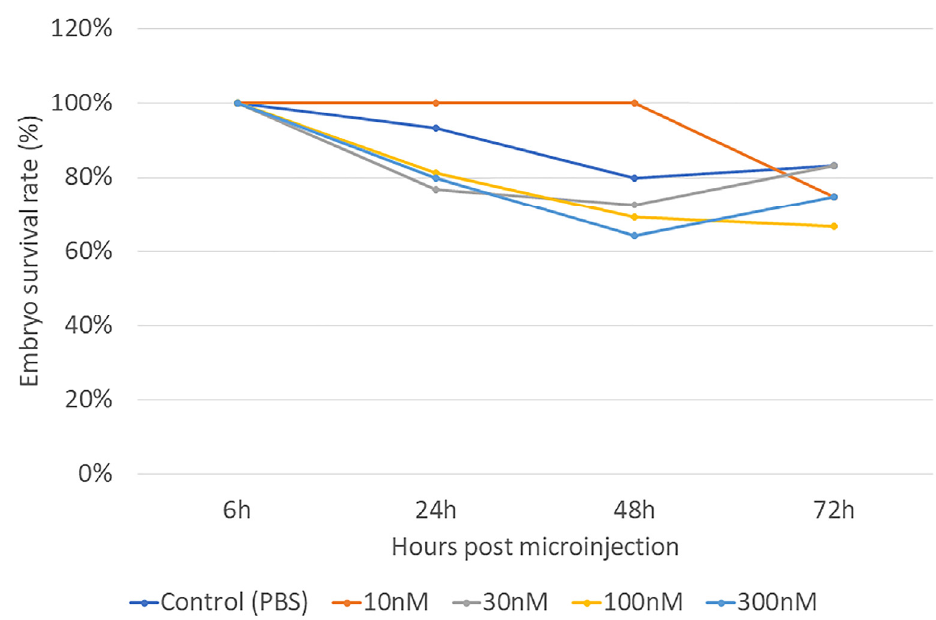
Figure 2. Embryo viability rate in the presence of different H 2 O 2 concentrations 6 h, 24 h, 48 h, and 72 h post-injection. The embryo survival rate was used to determine the toxicity level of the injected concentrations of H 2 O 2 . The results showed that the mortality rate did not depend on the treatment dose ( p = 0.226), but the incubation period had a significant impact on the survival rate ( p = 0.003). The embryonic survival rate means were submitted to two-way ANOVA by JMP Pro14.